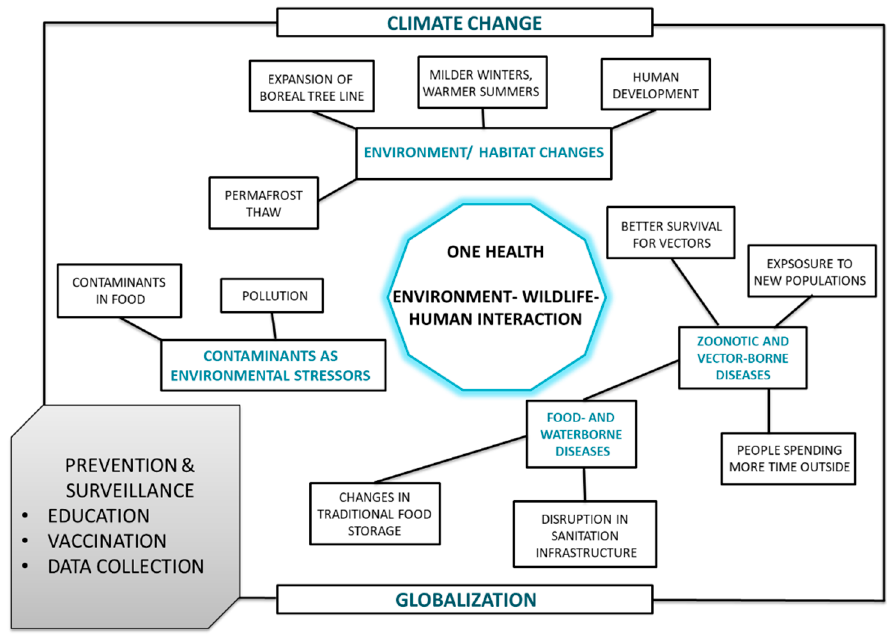
Figure 1. Environment—wildlife—human interactions in the context of climate change [2].